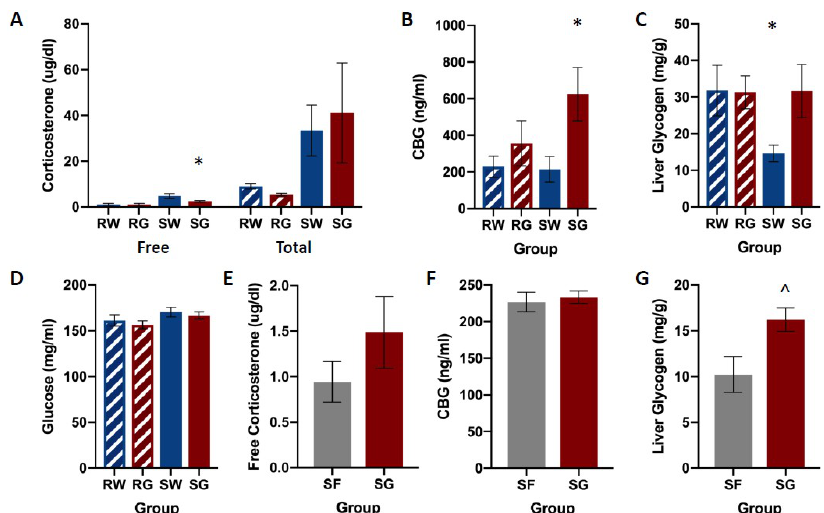
Figure 2. Corticosterone (panels A & E ), CBG (panels B & F ), liver glycogen (panels C & G ), and glucose (panel D ) concentrations among groups, following FR-1 shuttle-escape testing. Animals received either inescapable and unpredictable shock (S) or simple restraint (R). Following the stress session, animals were given 18-h free access to a 40% glucose cocktail (G), 40% fructose cocktail (F), or water (W). In shocked rats, glucose reduced free CORT, increased plasma CBG, and increased liver glycogen compared to water controls. However, CBG and corticosterone concentrations did not differ between shocked rats that received glucose or fructose. Liver glycogen concentrations were higher in shocked rats that received glucose compared to their fructose-drinking counterparts. Error bars denote mean ± SEM. * p < 0.05 (comparison: SG, SW), ^ p < 0.05 (comparison: SG, SF). Group on Free CORT, F(3, 28) = 20.039, p < 0.001, as well as a significant main effect of the Group on